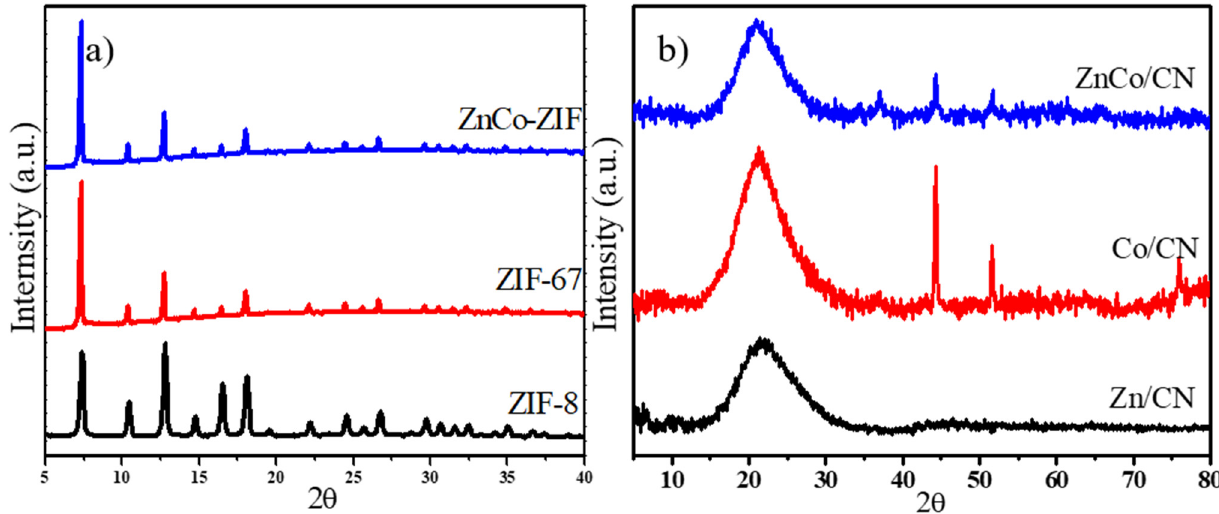
Figure 1. The pattern of XRD: ( a ) as-synthesized ZIFs, ( b ) pyrolyzed materials using different ZIF templates. Table 1. The porosity properties, CO 2 adsorption and C, N element analysis of porous carbon ma- terials deriving from ZIF templates.